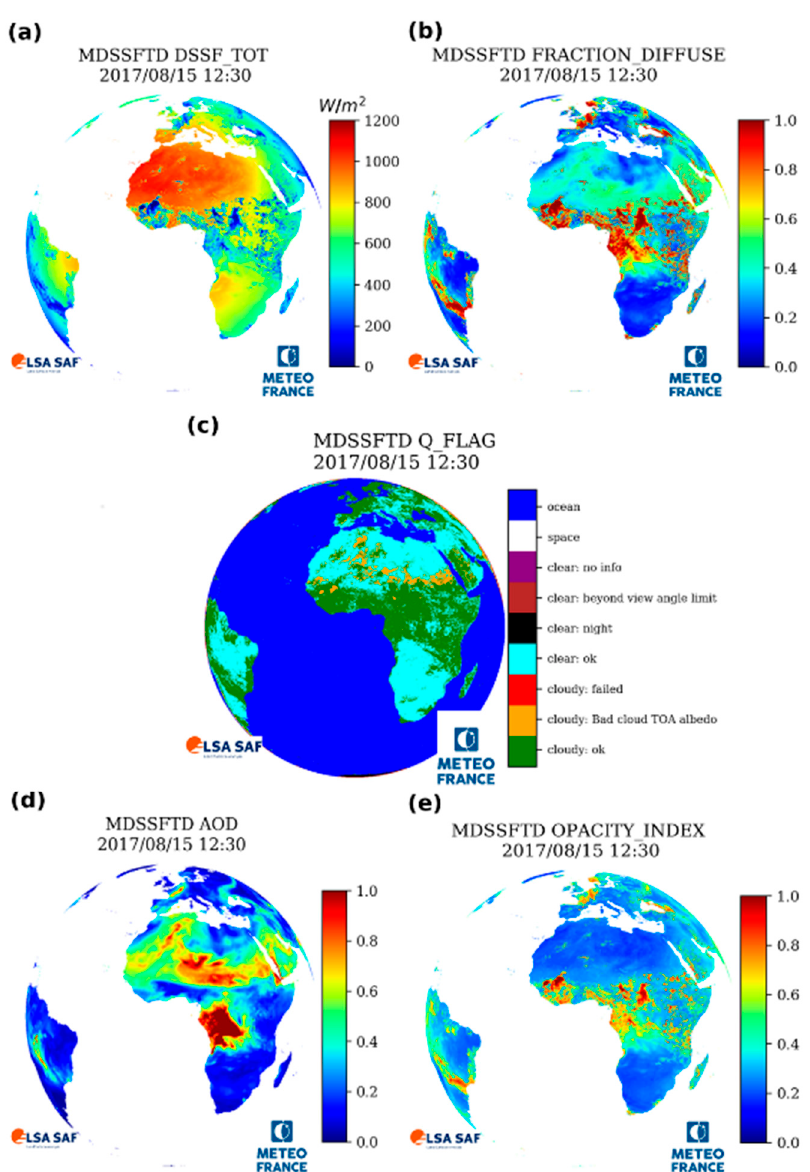
Figure 7. Full disk image of the distributed products: ( a ) Total DSSF flux, ( b ) Diffuse fraction of DSSF, ( c ) MDSSFTD Quality flag, ( d ) Equivalent spectral AOD at 550 nm, and ( e ) MDSSFTD opacity index.